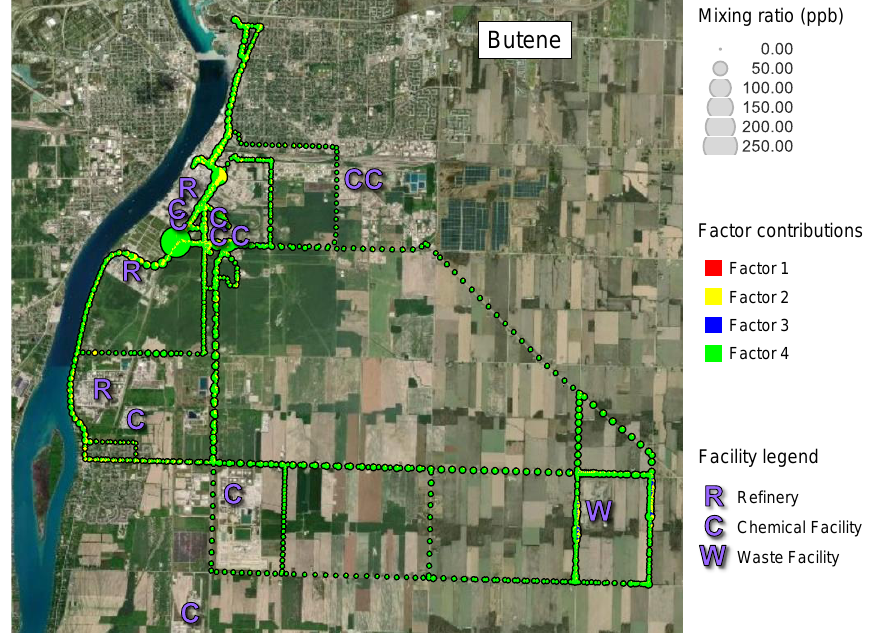
Figure 8. Contributions of each of the four local factors to butene mixing ratios as a function of measurement location while mobile. The diameter of each pie denotes the butene mixing ratio and the size of each wedge within each pie represents the relative contribution of each factor for that measurement period. It is important to note that reported butene mixing ratios should be considered as an upper limit due to interferences at m / z 57 from the fragmentation of alkanes. Figure 9 features a zoomed-in view of this region focusing on the mobile monitoring